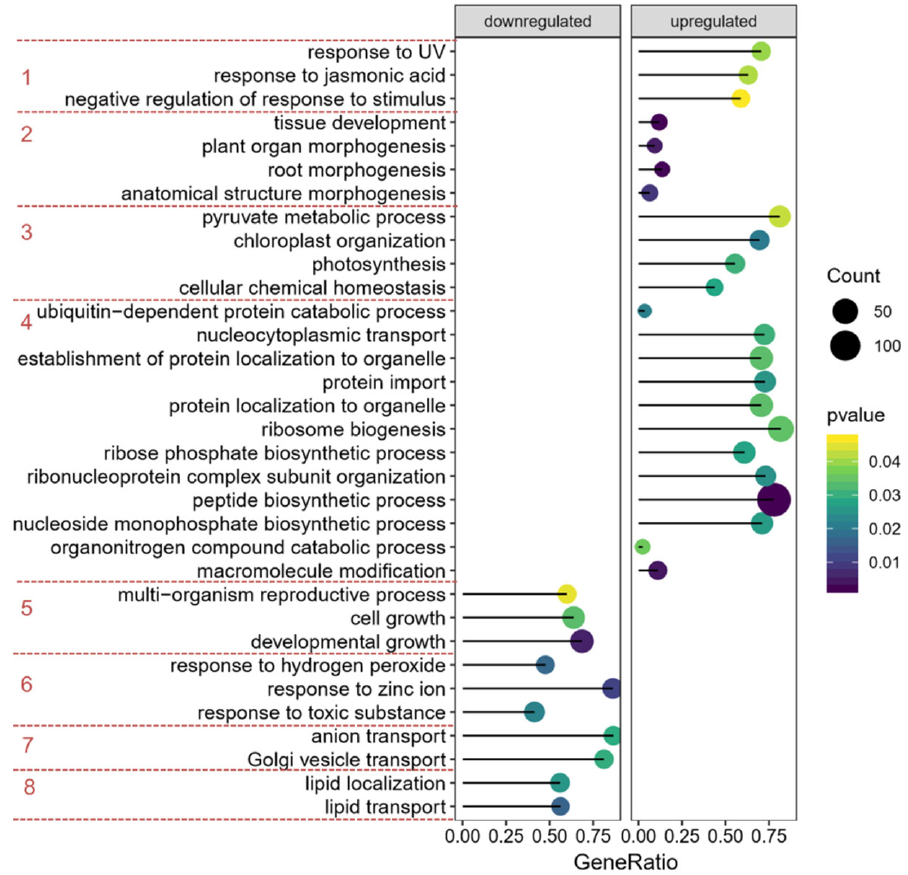
Figure 6. A dot plot of enriched BP terms in prt6 +/ prt6 − determined from GSEA results. The size of the dot represents count of the core proteins in each set, the color represents p value, and GeneRatio represents the number of core genes in gene set/the total number of genes in this gene set. The enriched BP terms were classified into several groups depending on functional connection and similarity, that is, class 1, response to stimuli; class 2, plant morphogenesis; class 3, energy metabolism; class 4, protein synthesis, localization and modification; class 5, development growth; class 6, response to stimuli; class 7, anion and Golgi transport; class 8, lipid transport and